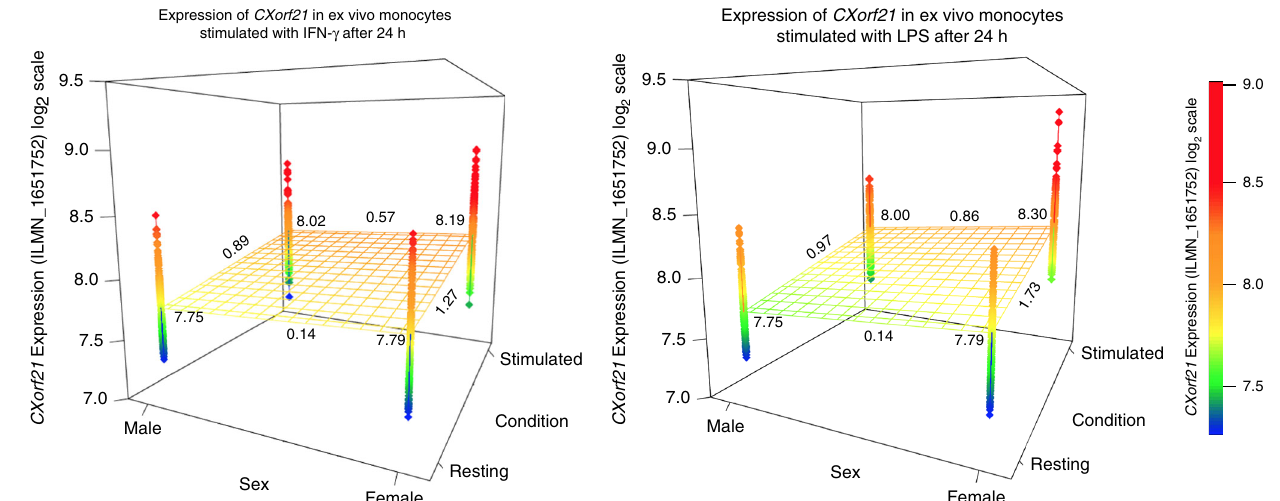
Fig. 4 Expression of CXorf21 in primary ex vivo cells strati fi ed on sex and cellular activation. CXorf21 expression data in resting and stimulated monocytes from healthy individuals of European ancestry derived from the Fairfax et al. studies (see Methods; n = 322 biologically independent samples). Samples were separated based on sex and activiation condition: following stimulation with interferon gamma (IFN- γ ) or with lipopolysaccharide (LPS) and harvested after 24 h. For each group, the mean is reported in the corners and the effect size (Cohen's d) is reported along the corresponding three-dimensional regression plane. Plots were constructed using plot3D for R. Source data are provided as a Source Data fi